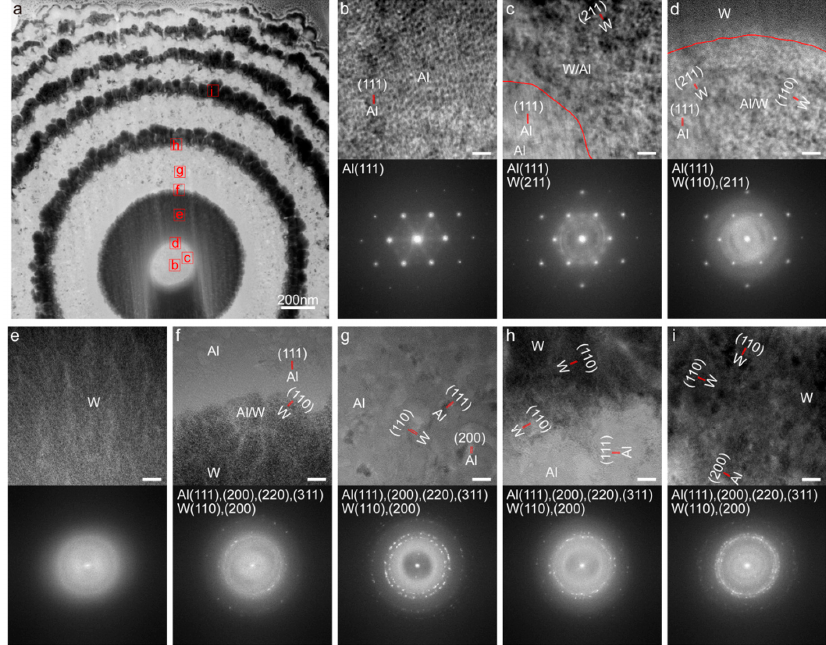
Figure 5. Crystal analysis of specimen. ( a ) TEM image of specimen. ( b – i ) HRTEM images (top) and corresponding SAED patterns (bottom) of these regions marked with red boxes in ( a ). Scale bar: 10 nm in ( b – i ).